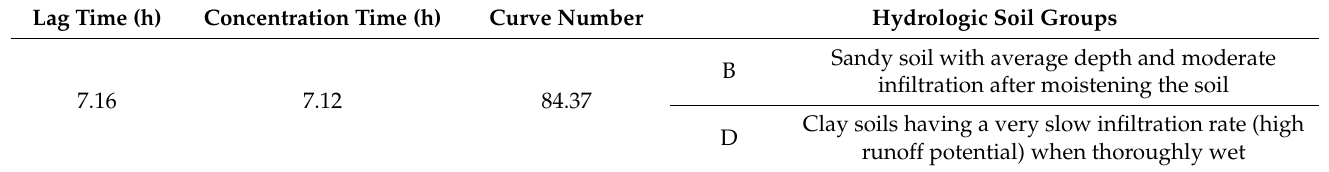
Table 8. Some hydrological characteristics of the Khazir River drainage basin.